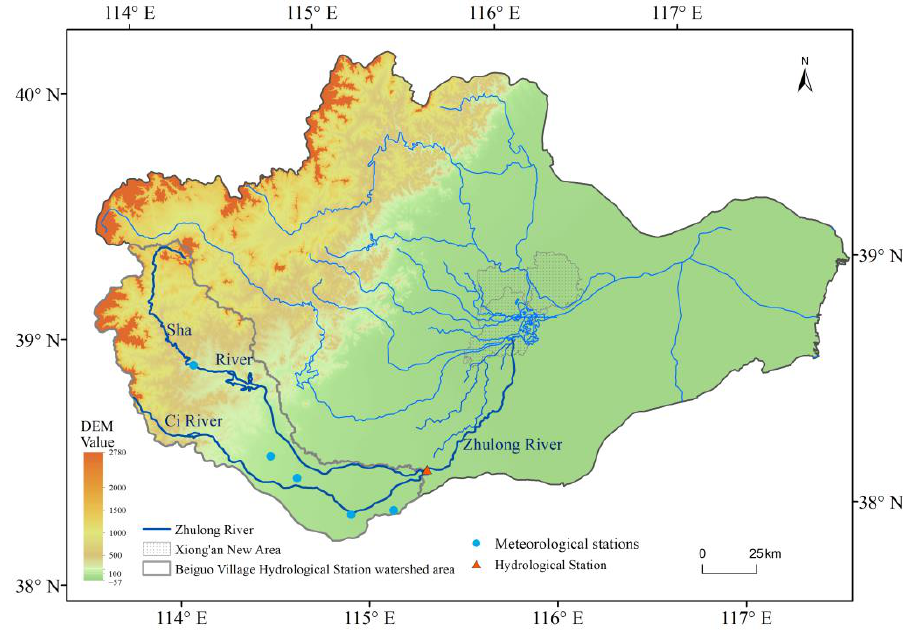
Figure 1. Study area and hydrological and meteorological stations.